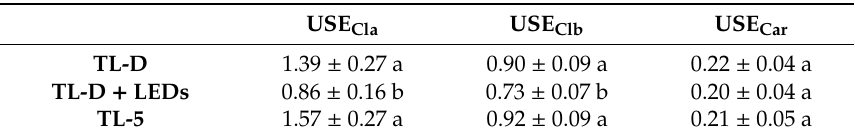
Figure 6. Use of spectral energy by each pigment of the crop (USEcrop) (chlorophyll a and b and carotenoids) in light treatments: ( a ) TL-D, ( b ) TL-D+LEDs and ( c ) TL-5. Table 4. Use of spectral energy by each pigment (USEpigment) (chlorophyll a and b and carotenoids) (expressed in W m − 2 ) in each light treatment. Values with the same letters are not significantly di ff erent at p < 0.05 (ANOVA and LSD test). ns: not significant. Data are the means ± standard deviation of five plants per treatment.